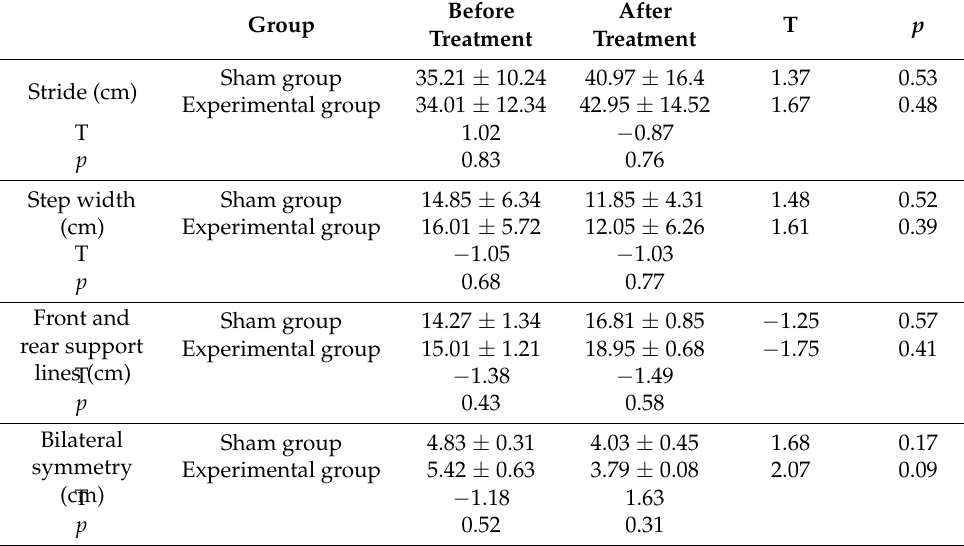
Table 6. Gait analysis and plantar pressure parameters.